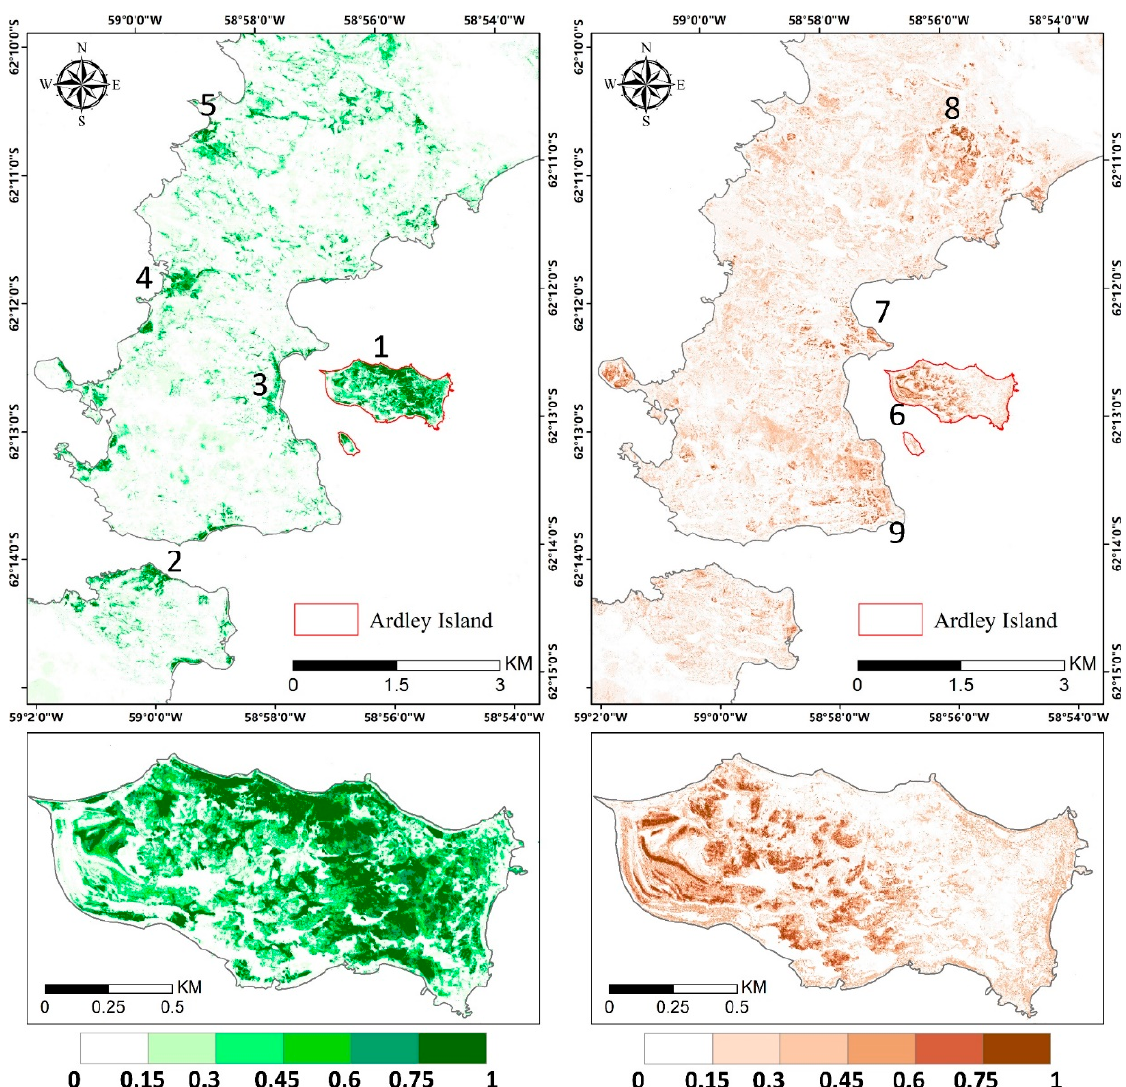
Figure 9. Vegetation abundance maps derived with modified Nascimento’s model for Antarctic vegetated areas (MNM-AV)3 (the best model) for mosses and lichens in the left and right panel, respectively. Regions 1–5 highlight regions with a high abundance of mosses, and regions 6–9 are regions with a high abundance of lichens. The red box indicates the area of the zoom window. Table 5. Confusion matrix of mosses health evaluation.